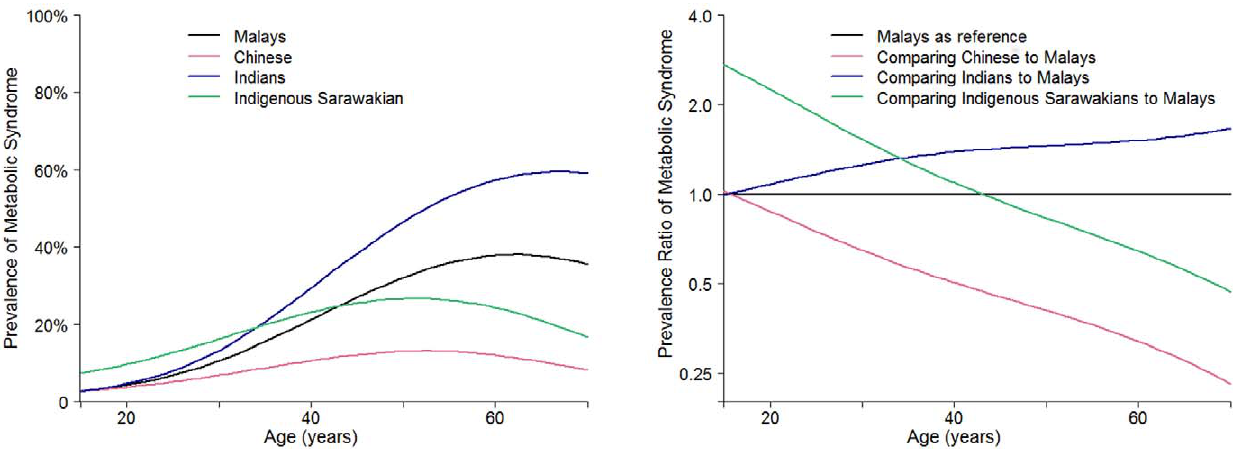
Figure 1. Age-variation in prevalence of metabolic syndrome by ethnicity. Prevalence estimates of metabolic syndrome and prevalence ratios were derived from restricted cubic splines models with knots at the 10 th , 50 th , and 90 th percentiles of the overall age distribution. Models were adjusted for age, gender, smoking status, highest attained education, urban residence, family history of diabetes, and family history of hypertension.